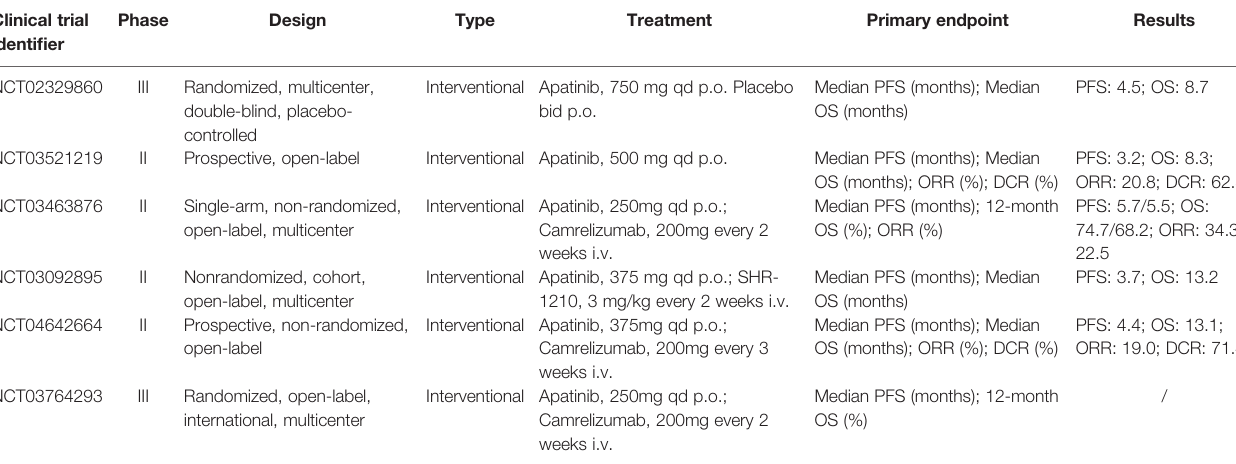
TABLE 2 | Selected clinical trials with apatinib in liver cancer and cholangiocarcinoma. Clinical trial identi fi